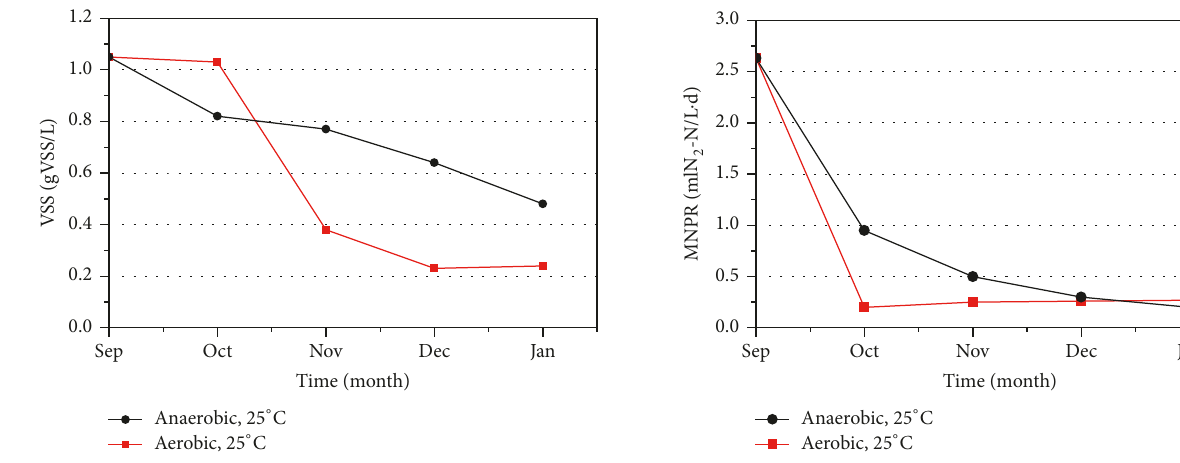
(mg COD mg NH 4 -N −1 ), and 𝑘 is the maximum specific nitrogen gas production rate (mLN 2 -N L −1 d −1 mg COD −1